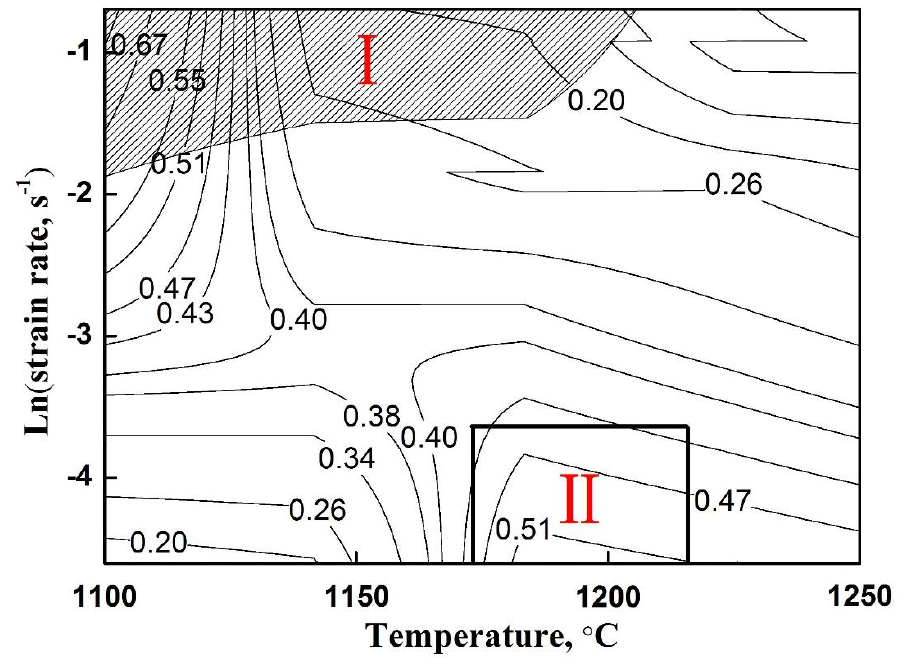
Figure 3. Processing map of the Ti–43Al–3Mn–2Nb–0.1Y alloy.